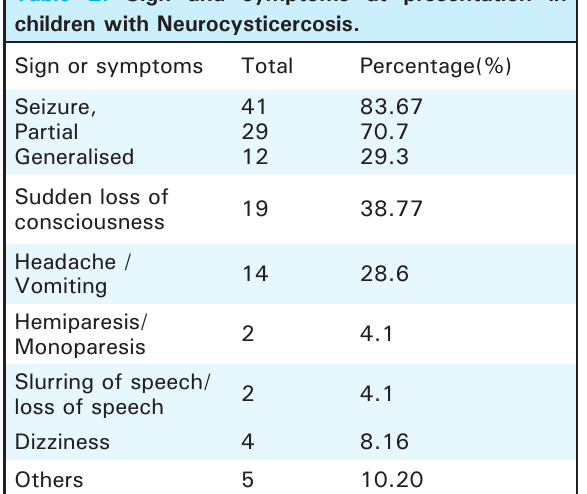
Table 2. Sign and symptoms at presentation in children with Neurocysticercosis.